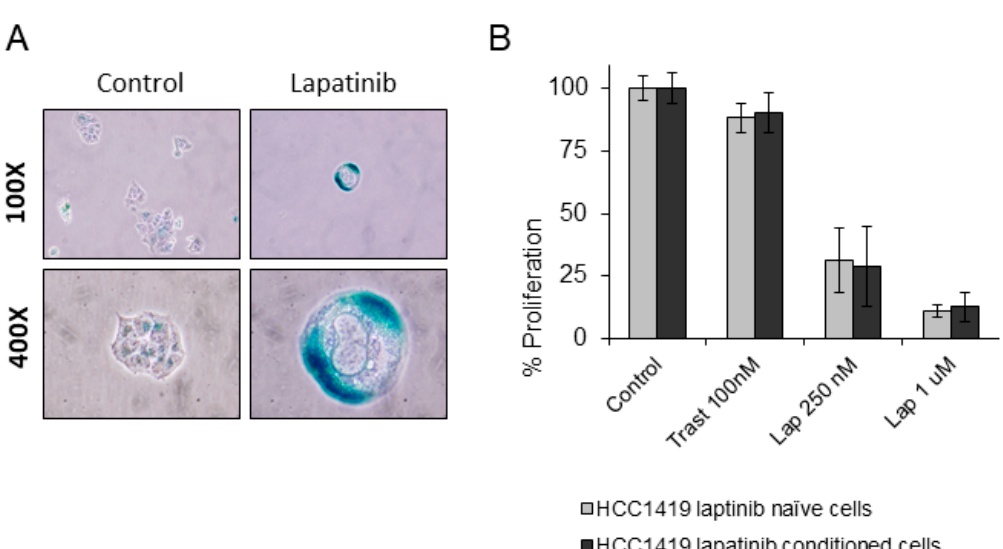
Figure 6. ( A ) HCC1419 cells were treated twice weekly with 250 nM lapatinib for 6 months. The resulting cells were tested for SA- β -gal activity. Images taken at 100 × and 400 × magnification. ( B ) The effects of trastuzumab and high and low dose lapatinib on HCC1419 cells which were lapatinib naïve or which had been previously conditioned for 6 months with 250 nM lapatinib followed by 3 months growth in lapatinib-free media. Cells were treated with the indicated concentrations of drug and then growth was measured after 5 days and is expressed relative to untreated control cells (error bars reflect n = 3).